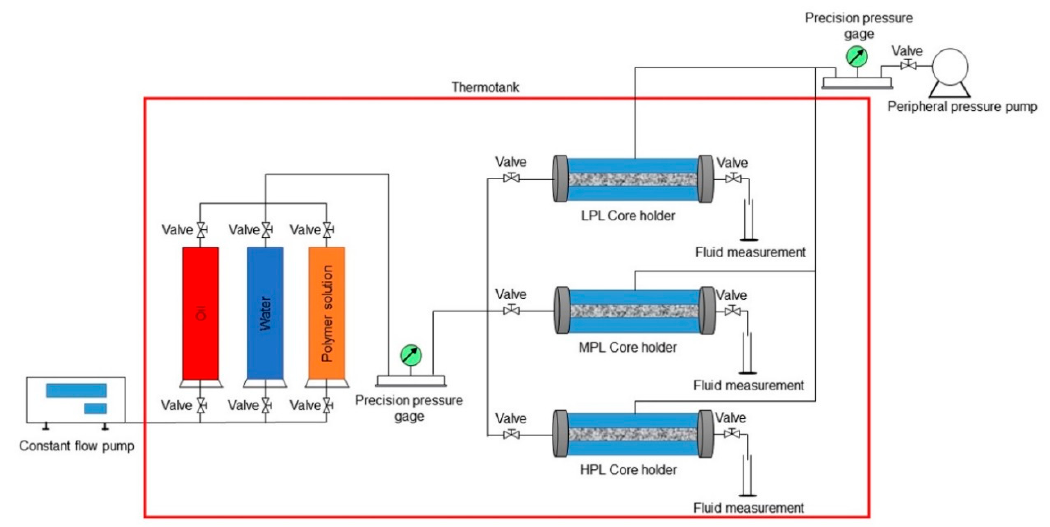
Figure 2. The schematic of a polymer flooding